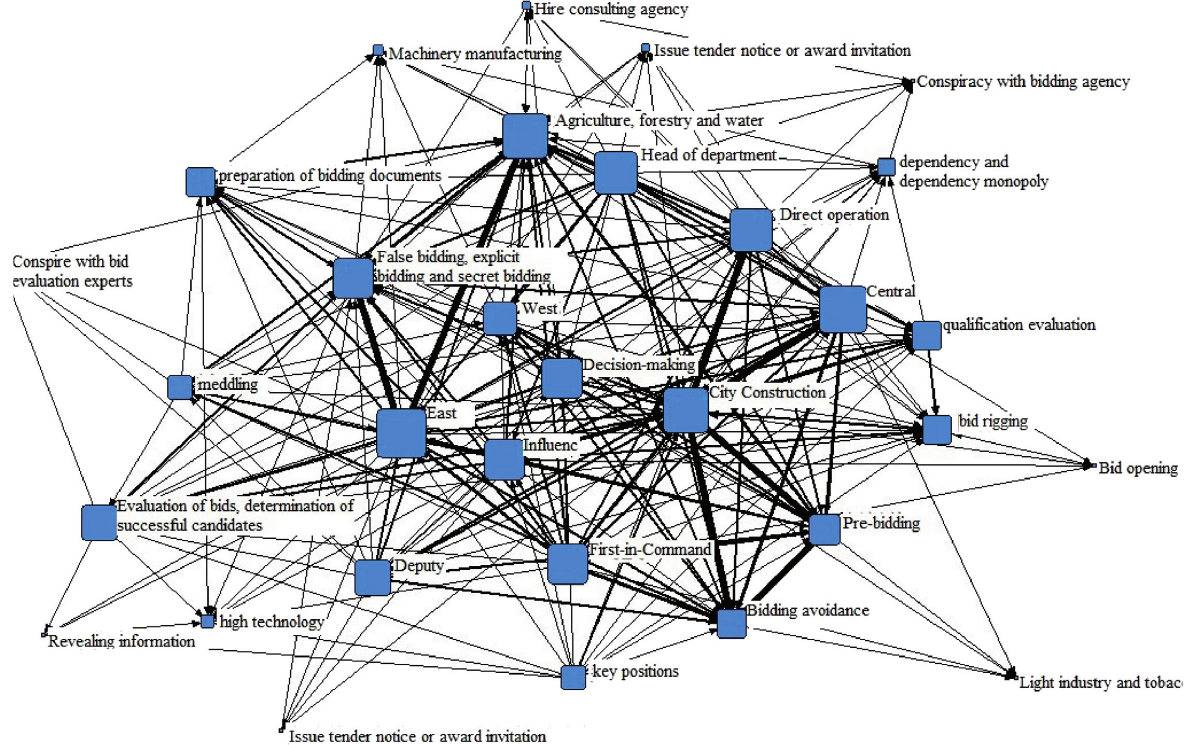
Figure 5: Copresence network of opportunistic collusion variables. Table 3: Centrality of opportunistic collusion